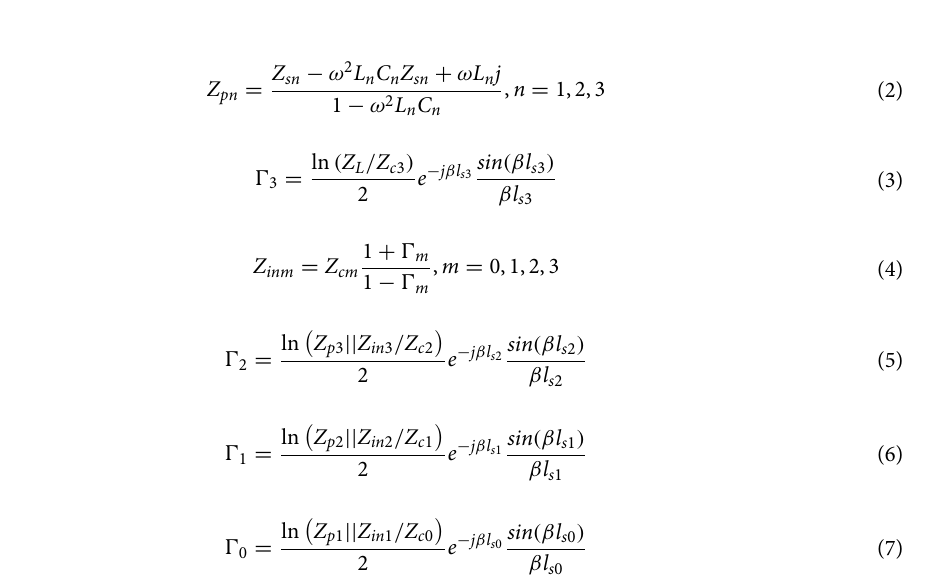
Figure 2. Scheme of the optical Vivaldi antenna with its main parameters: ( a ) global view; ( b ) the feeding microstrip line on bottom copper